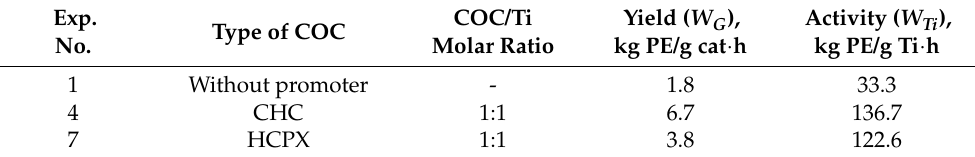
Table 1. The effect of COCs on activity of TMC during ethylene homopolymerization.